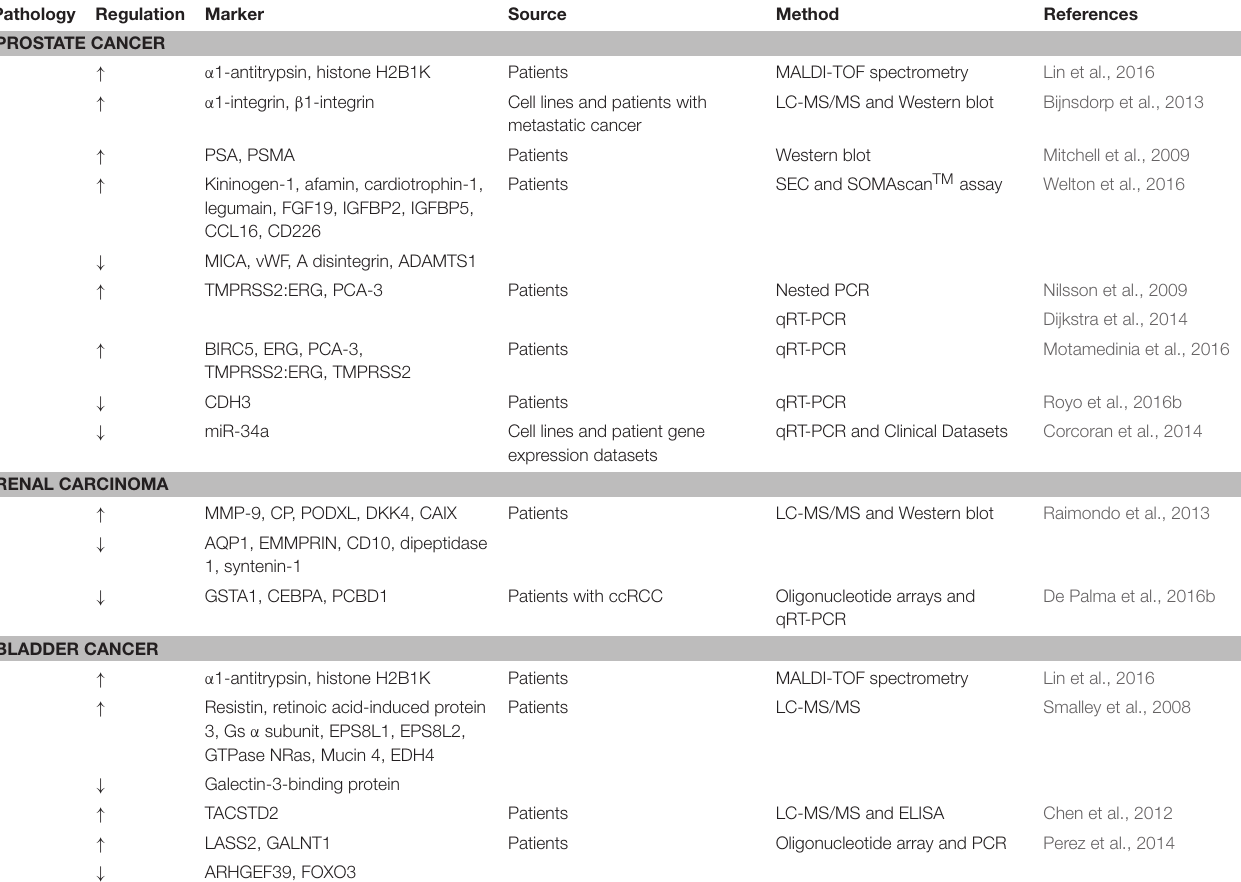
TABLE 1 | Candidate uEV biomarkers for urologic